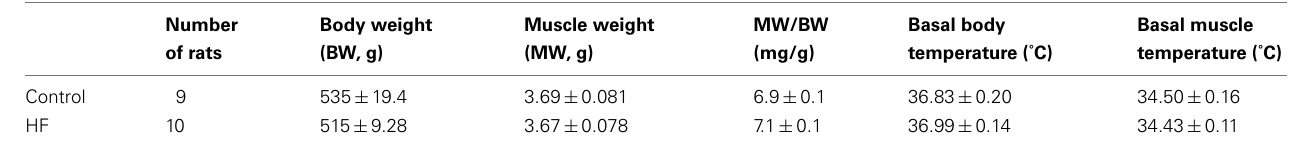
Table 2 | Muscle characteristics.